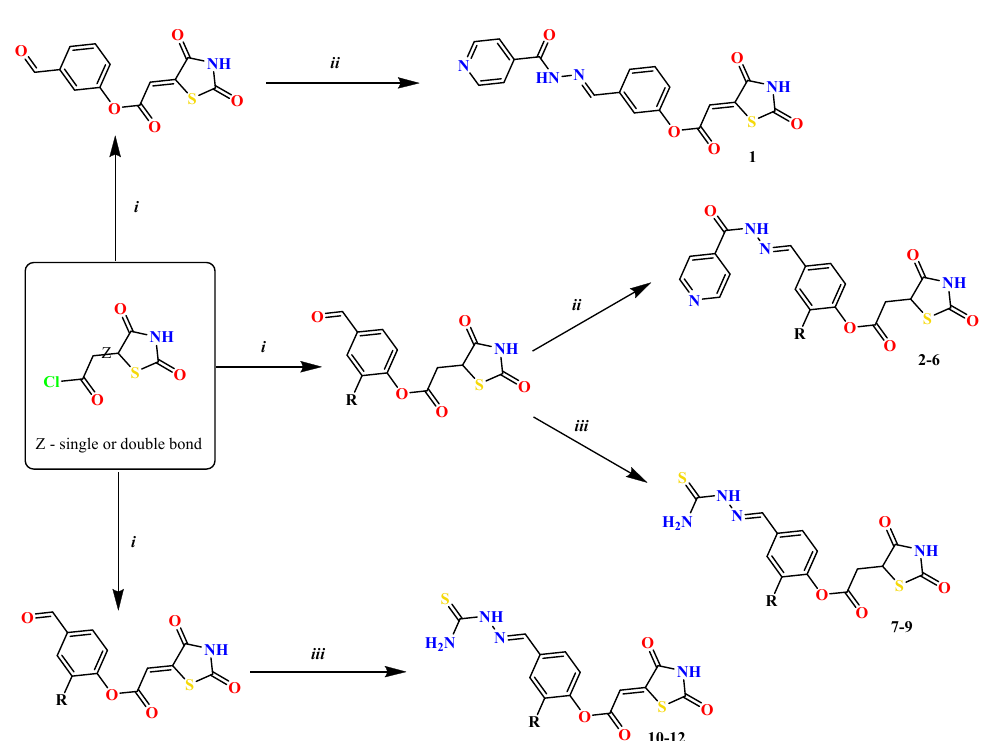
Figure 2. Synthetic route for TZD-PCH ( 1 – 6 ) and TZD-TSC ( 7 – 12 ) hybrid molecules. Reagent and conditions : ( i ) corresponding hydroxybenzaldehyde, pyridine, 1,4-dioxane, rt, 2h, acidified with dilute HCl; ( ii ) isonicotinic acid hydrazide, anhydrous ethanol, reflux; ( iii ) TSC, anhydrous ethanol, reflux. For the numbers used to identify the TZD hybrid molecules ( 1 – 12 ), see Table 1.